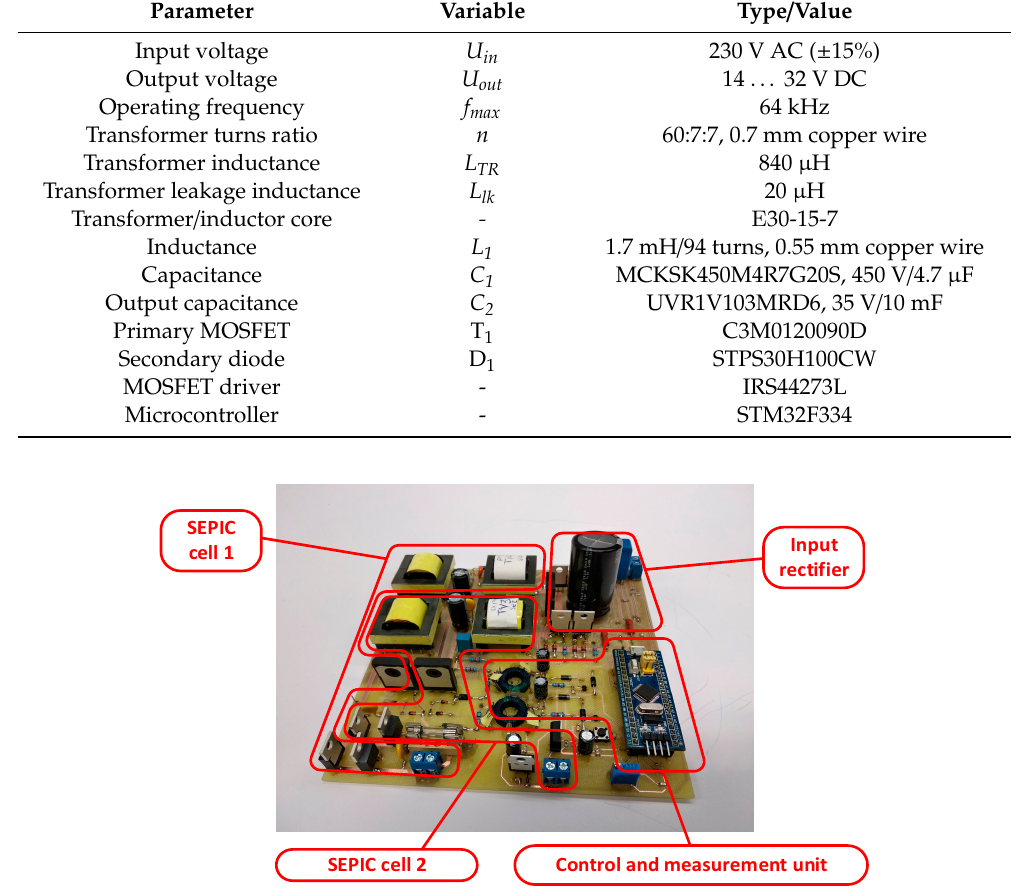
Table 4. Main parameters and components of the experimental converter.